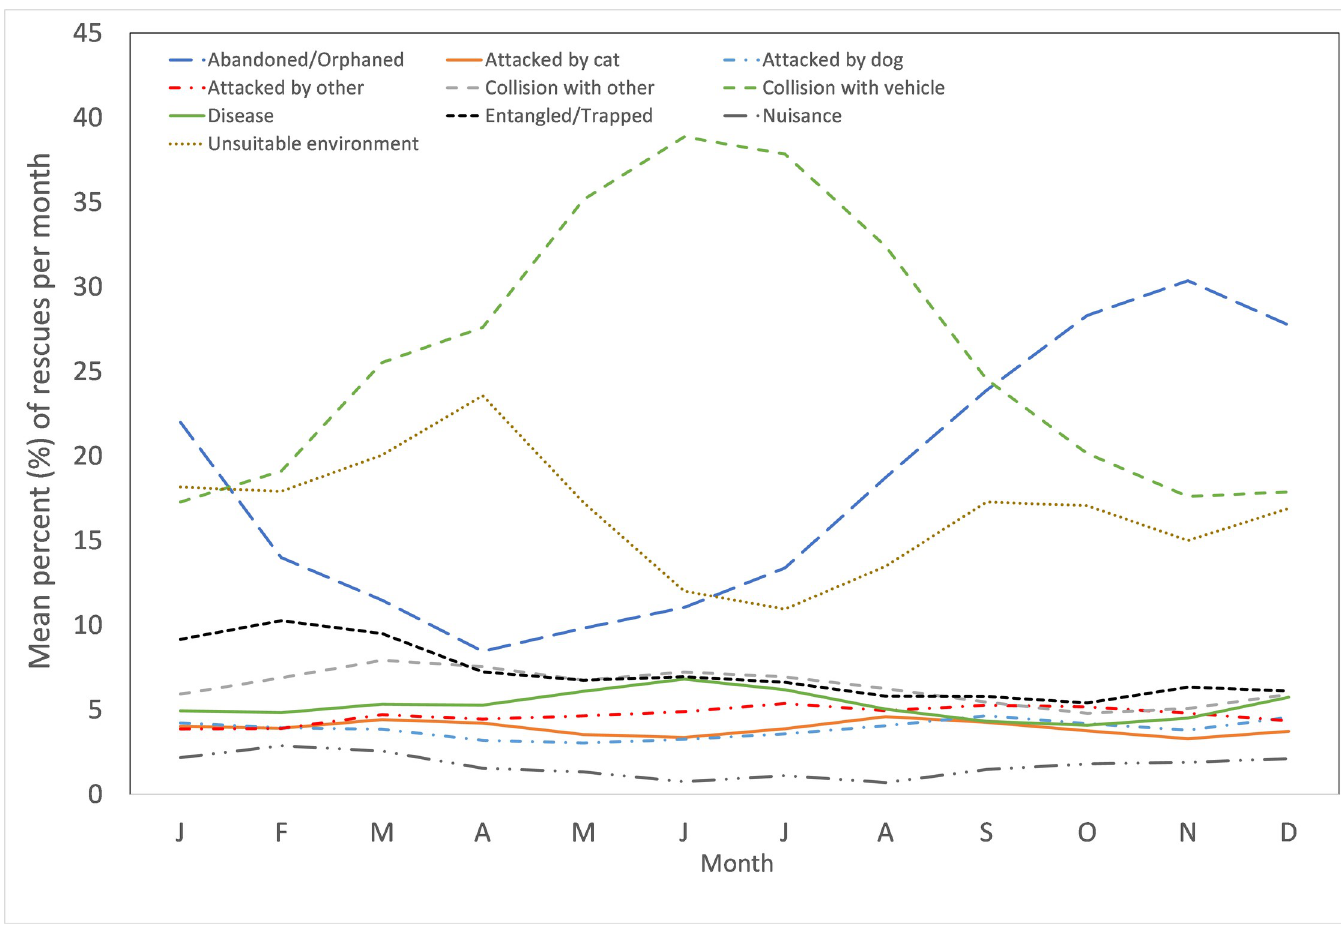
Fig 8. Percent (%) of rescues attributable to each of top 8 pooled causes for rescues within each month.